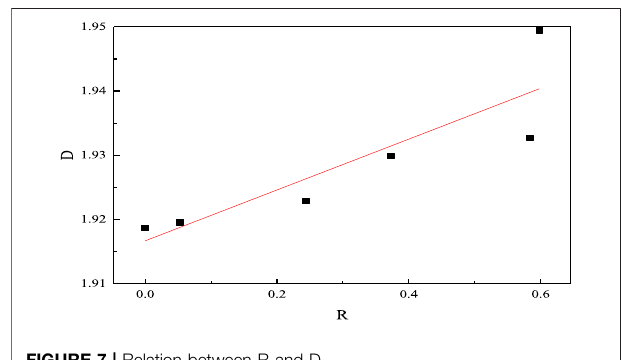
FIGURE 7 | Relation between R and